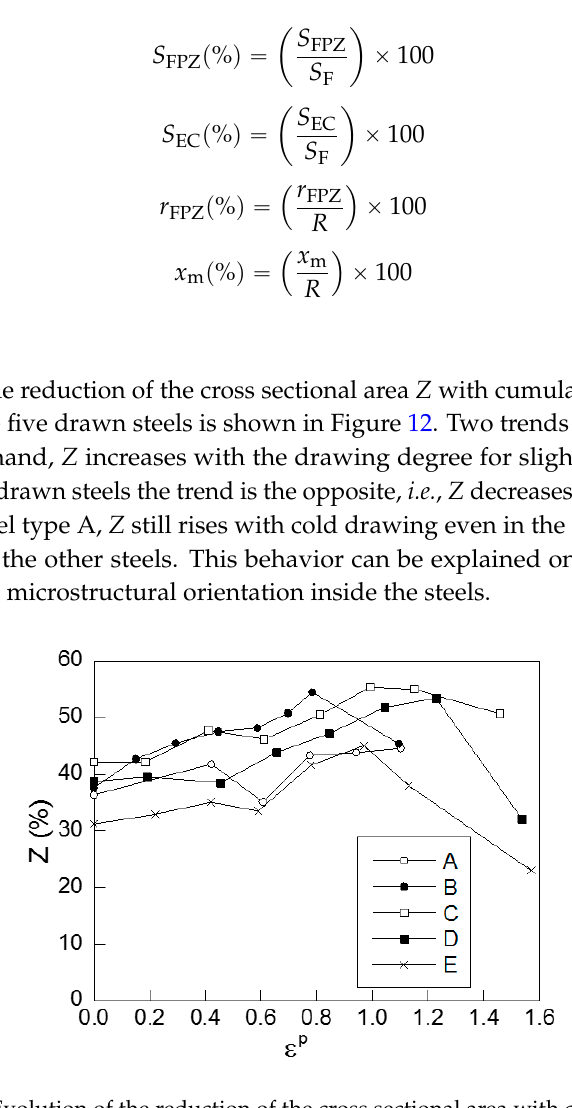
Figure 12. Evolution of the reduction of the cross sectional area with cold drawing.